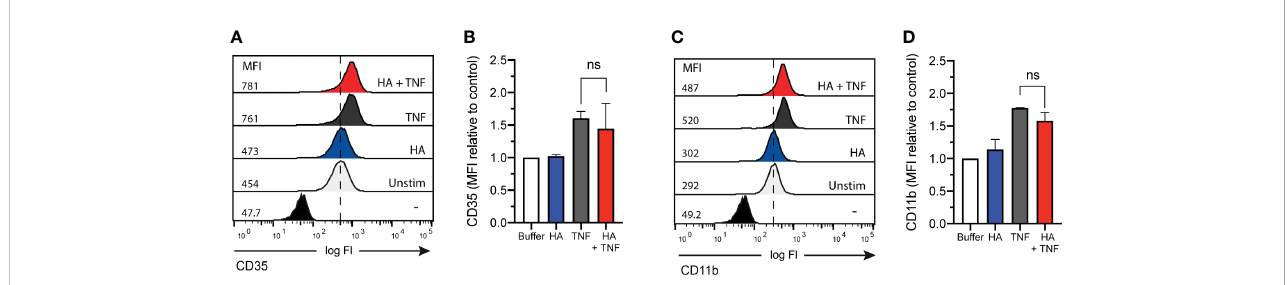
FIGURE 3 CD35 and CD11b surface expression on co-primed neutrophils. (A) CD35 and (C) CD11b surface expression (x-axis; log fl uorescence intensity (log Fl)) on neutrophils (y-axis; cell counts) following incubation in the absence (unstimulated without (-) and with (Unstim) antibody staining) and presence of HA (200 m g/mL), TNF a (10 ng/mL), or TNF a and HA. Data is representative of 3 experiments. Bar graphs show mean (B) CD35 and (D) CD11b fl uorescence (y-axis; + SD) for no stimulation, HA, TNF a , and HA + TNF a normalized to control (buffer, unstimulated). Statistical analysis was performed using ordinary one-way ANOVA followed by Sidak's multiple comparison test, (B, D) ; ns - not signi fi cant.